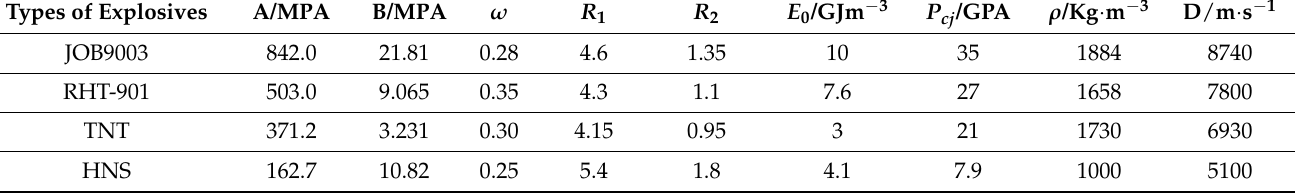
Table 5. Parameters related to the JWL constitutive equation of explosives.